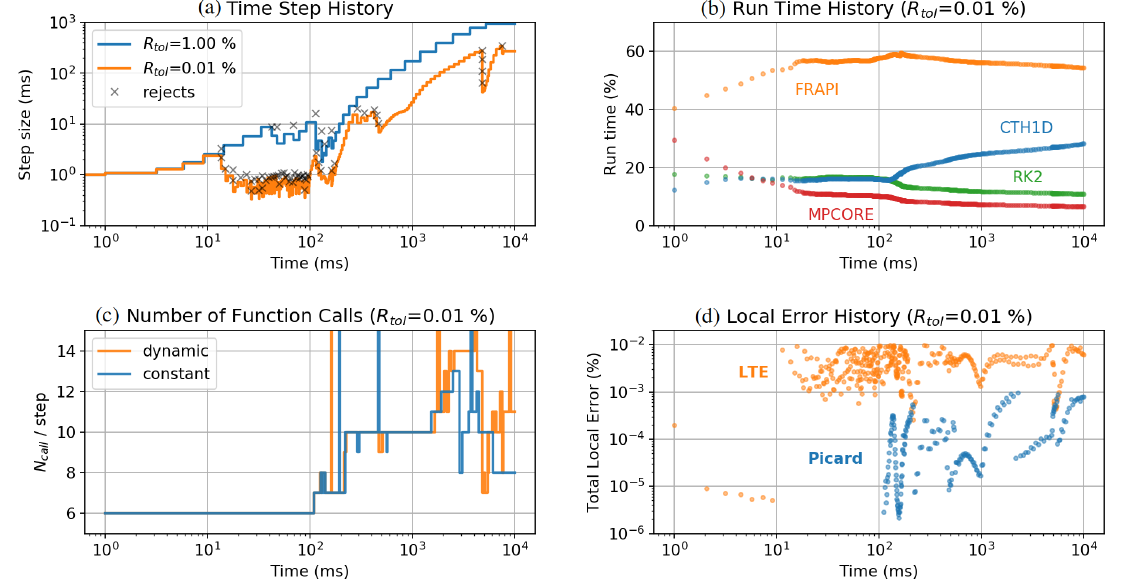
Figure 8. Full-core rod ejection accident performance for relative tolerance R tol = 0.01%: ( a ) time step size, ( b ) code run-time, ( c ) function calls number, and ( d ) local truncation error as the functions of